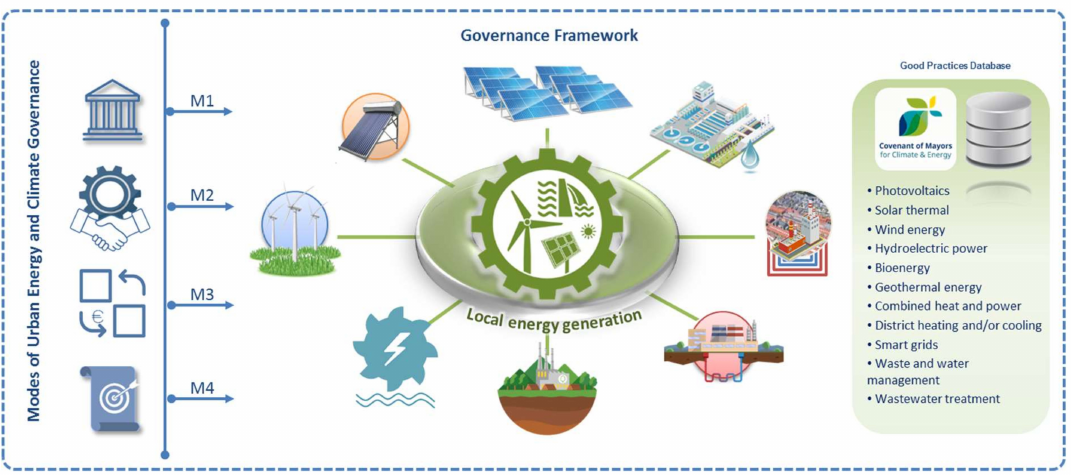
Figure 2. Necessity for a coherent policy mix for local energy generation. Source: own